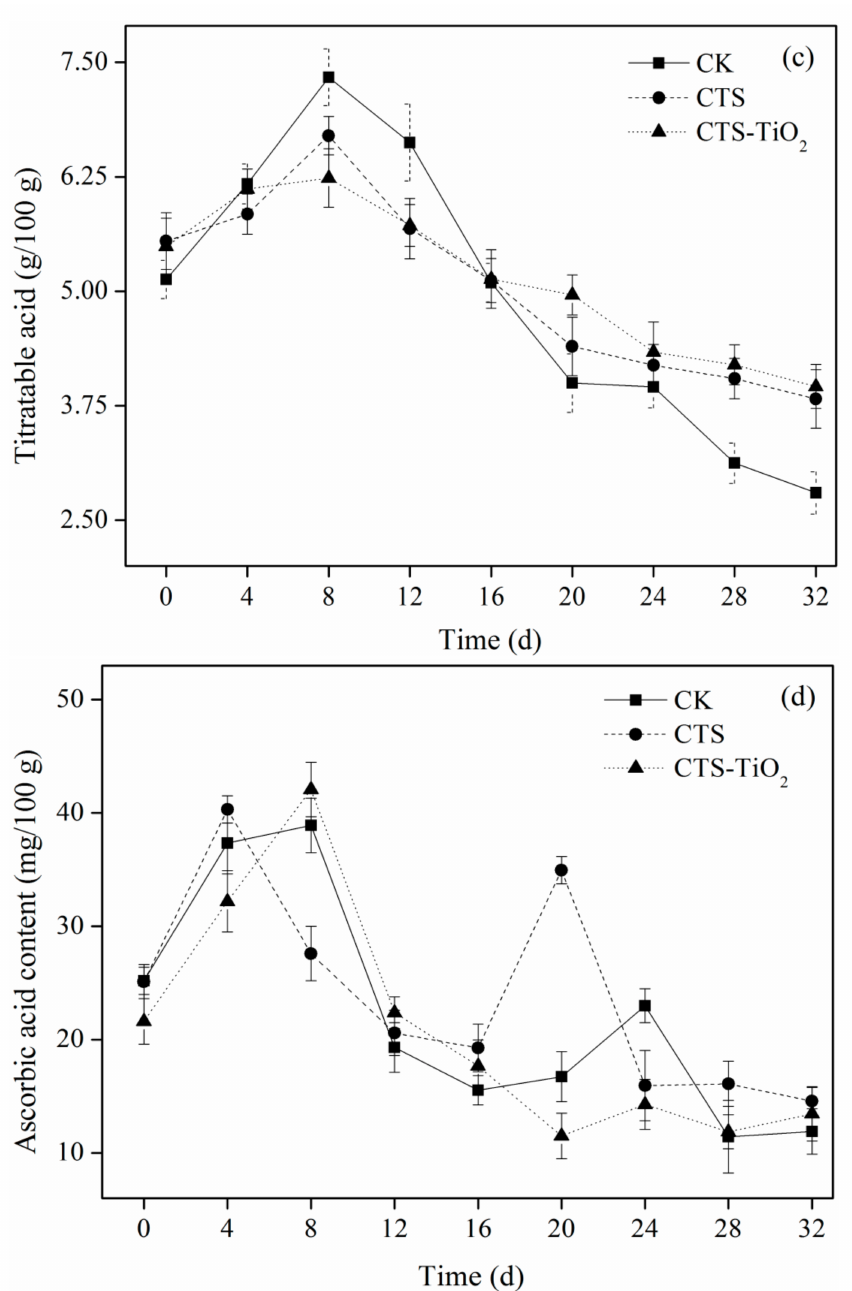
Figure 1. Effects of different treatments on the firmness ( a ), TSS ( b ), TA ( c ), and ascorbic acid content ( d ) of blueberry fruit during 32 days of storage at 0 ◦ C (CK stands for no coating; CTS stands for chitosan coating; CTS-TiO 2 stands for chitosan/nano-TiO 2